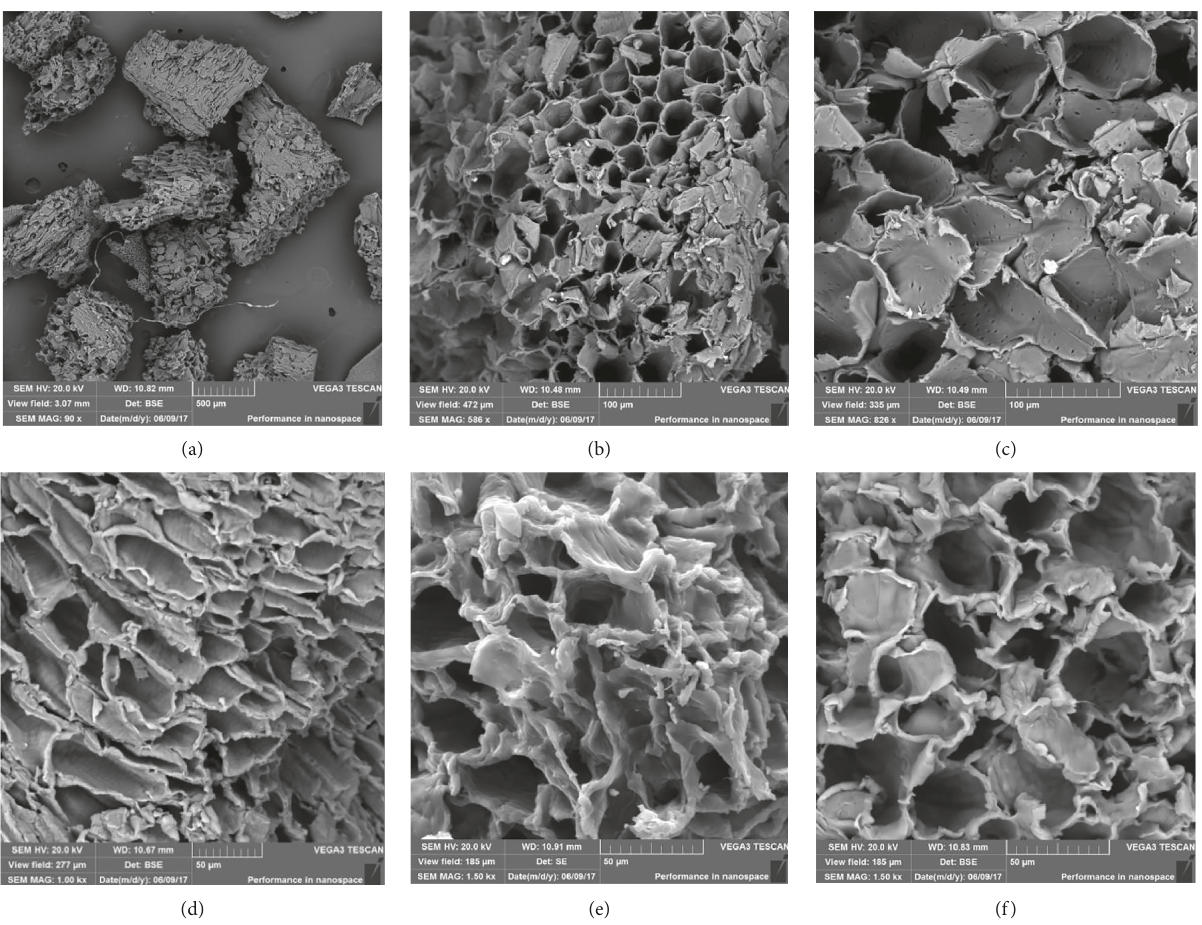
Figure 8: SEM micrographs of LVS biomass (a, b), MLV precursor (c), and CALV biosorbent before (d) and after phosphate (e) and nitrate (f)